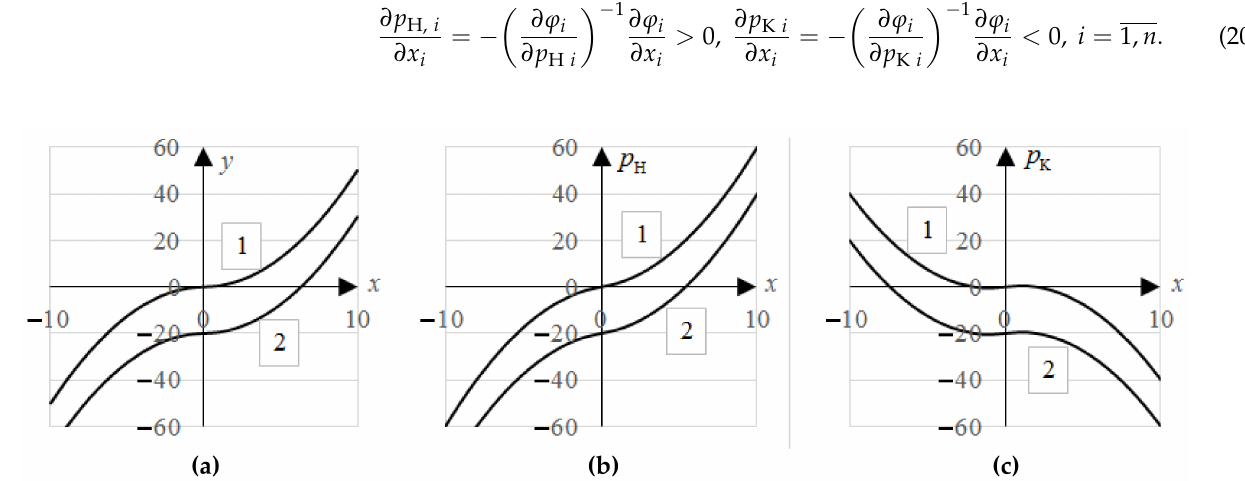
Figure 2. Charts of conventional flow models for the passive (1) and active (2) branches of the HC in coordinates: ( a ) ( x , y ) ; ( b ) ( p H , x ) ; ( c ) ( p K , x )